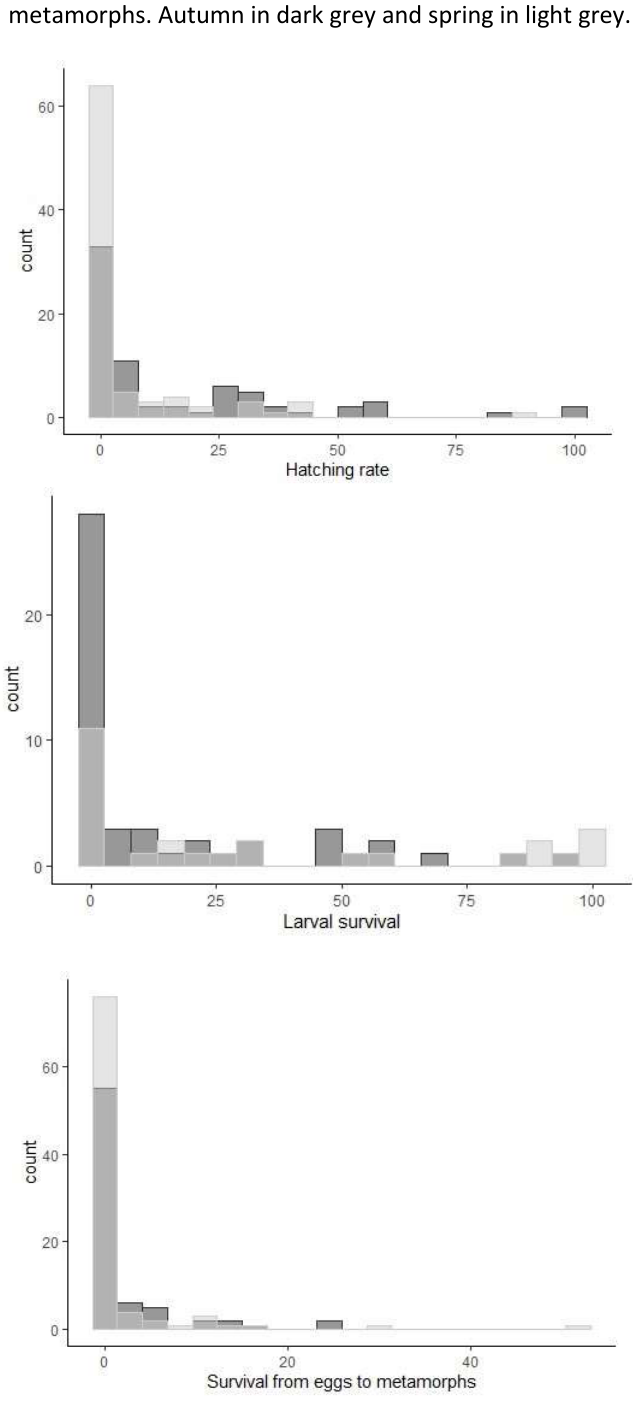
Annex 3: Distribution of hatching rate, survival rate during larval stage and survival rate from eggs to metamorphs. Autumn in dark grey and spring in light